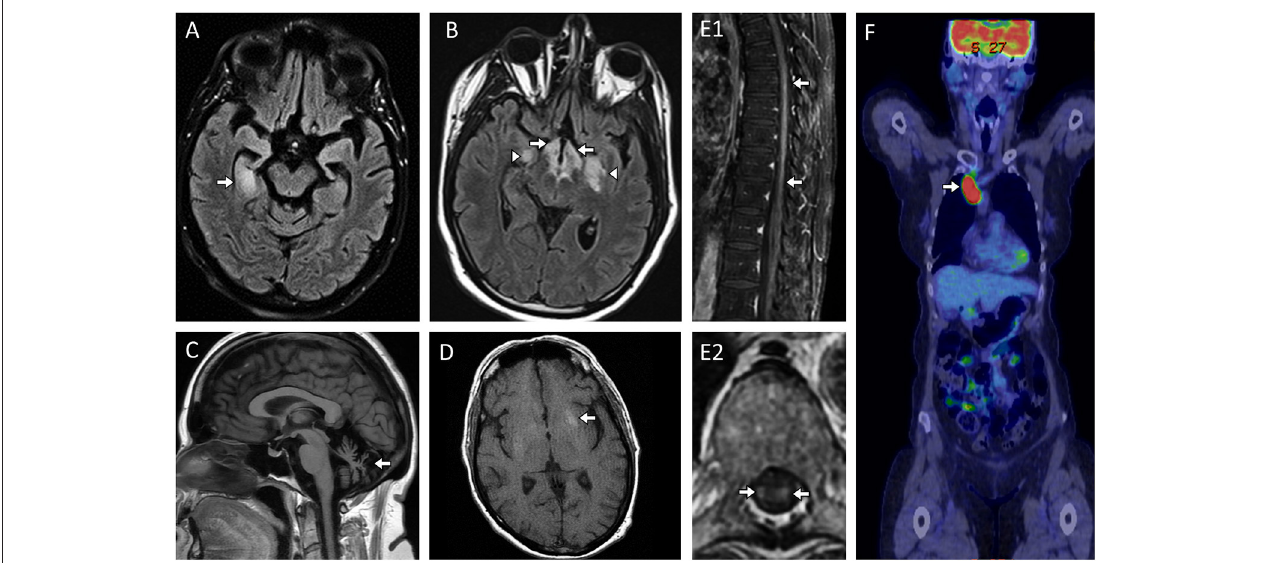
FIGURE 1 | MRI abnormalities in patients with paraneoplastic and other non-demyelinating antibody-mediated CNS disorders. (A) Paraneoplastic limbic encephalitis with antineuronal nuclear antibody type 1 (ANNA-1/anti-Hu) with MRI head axial FLAIR image revealing unilateral T2-hyperintensity in the right mesial temporal lobe [ (A) , arrow]; (B) Paraneoplastic narcolepsy-cataplexy and limbic encephalitis with Ma-2/Ta antibodies and MRI axial FLAIR image revealing bilateral T2-hyperintensity in the hypothalamus [ (B) , arrows] and bilateral mesial temporal lobes [ (B) , arrowheads]; (C) Progressive cerebellar ataxia with neurochondrin autoantibodies and MRI head sagittal T1-weighted images without gadolinium revealing severe cerebellar atrophy [ (C) , arrow]; (D) Facio-brachial dystonic seizures with leucine-rich-glioma-inactivated-1 (LGI1) antibodies with MRI head axial T1-weighted images without contrast administration revealing T1-hyperintensity in the left basal ganglia [ (D) , arrow]; (E) Paraneoplastic myelopathy accompanying small cell lung cancer without an identified neural autoantibody with MRI spine T1-weighted sagittal and axial images with gadolinium revealing enhancement within the spinal cord parenchyma [ (E1, E2) : arrows] which on axial images was restricted to the bilateral lateral columns [ (E2) , arrows) which is a hallmark imaging finding with paraneoplastic myelopathy; (F) Paraneoplastic encephalitis with α -amino-3-hydroxy-5-methyl-4-isoxazolepropionic acid (AMPA) receptor antibodies and 18F-Flludeoxyglucose-positron-emission-tomography (FDG-PET) body revealing markedly increased glucose uptake in the right paratracheal region [ (F) , arrow] with subsequent biopsy revealing metastatic small cell lung cancer.